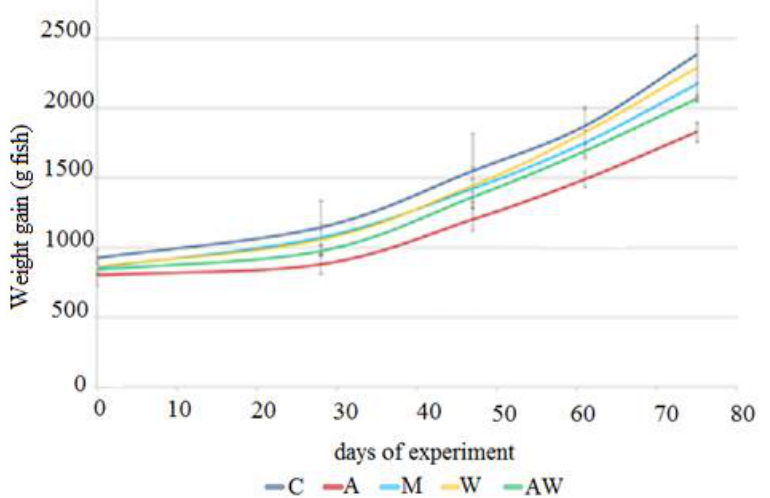
Figure 1. Trends of average gains of rainbow trout fed the 5 experimental diets across the feeding trial. A, Delesseria sanguinea combined diet; M, Mytilus spp. combined diet; W, Alitta virens combined diet; AW, Alitta virens + Delesseria sanguinea combined diet. The fish in the C diet group (control) had a moderately higher final weight, with an average daily gain (ADG) of 0.018 g/d. The lowest ADG (0.014 g/d) was recorded for fish fed the red algae, Delesseria sanguinea, combined diet (A diet group), with the average final body weight being 23.9% lower than that achieved for fish fed the control diet (C diet group). However, no significant differences were found in regards to weight gain among the experimental groups. The best growth performance, based on data recorded for the combined experimental diets, was observed for fish fed the W diet (king ragworms, Alitta virens, ADG 0.018 g/d), followed by fish fed the blue mussel combined diet (M diet, ADG 0.018 g/d), in light of the FCR. The FCRs of all the test feeds are shown in Figure 2.